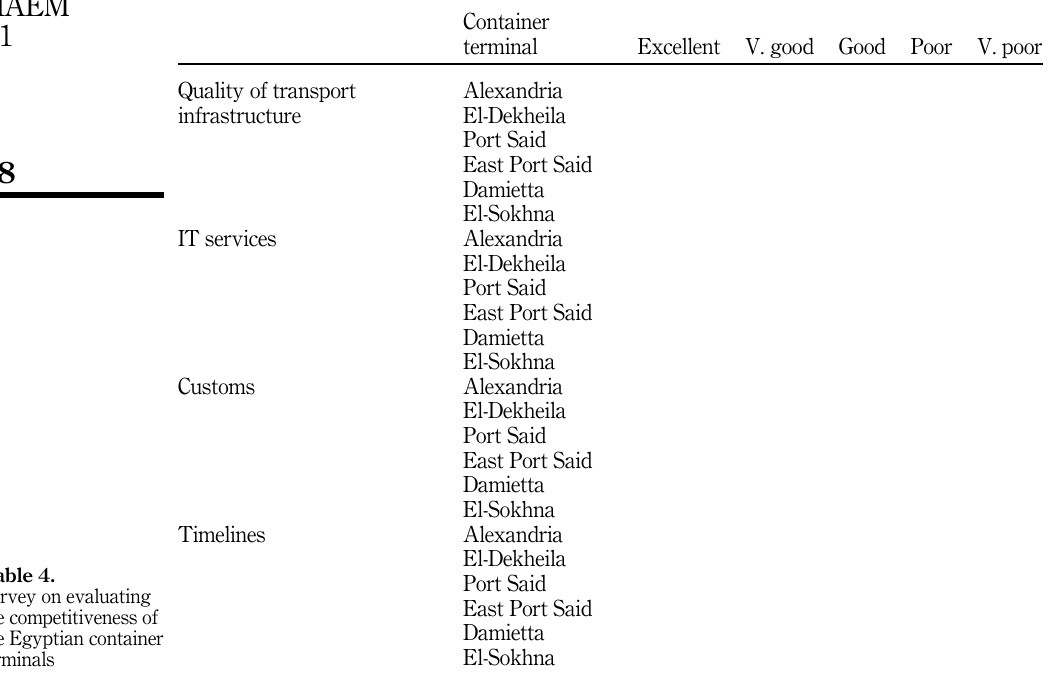
Table 4. Survey on evaluating the competitiveness of the Egyptian container terminals